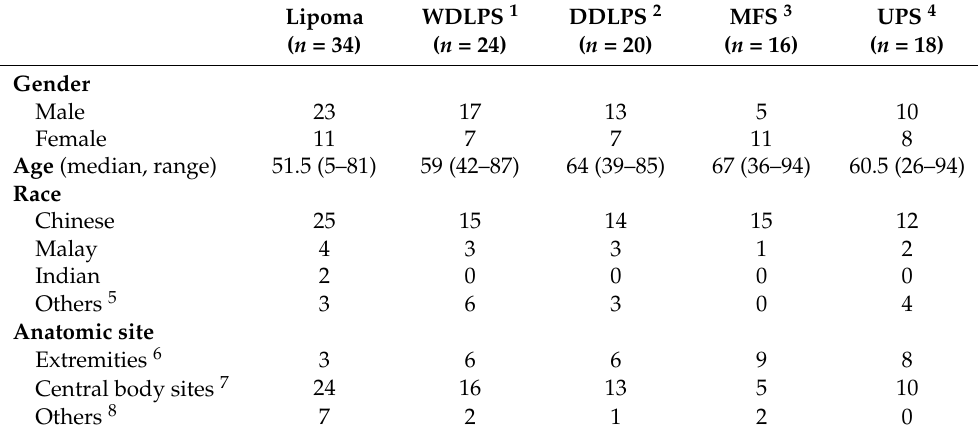
Table 4. Summary of demographics and characteristics of patient samples